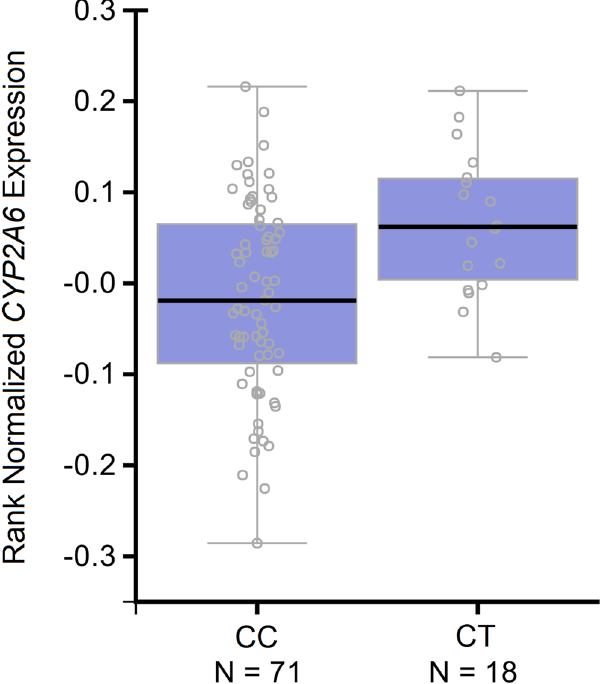
Figure 2. CYP2A6 expression across rs113288603 genotypes in cerebellar